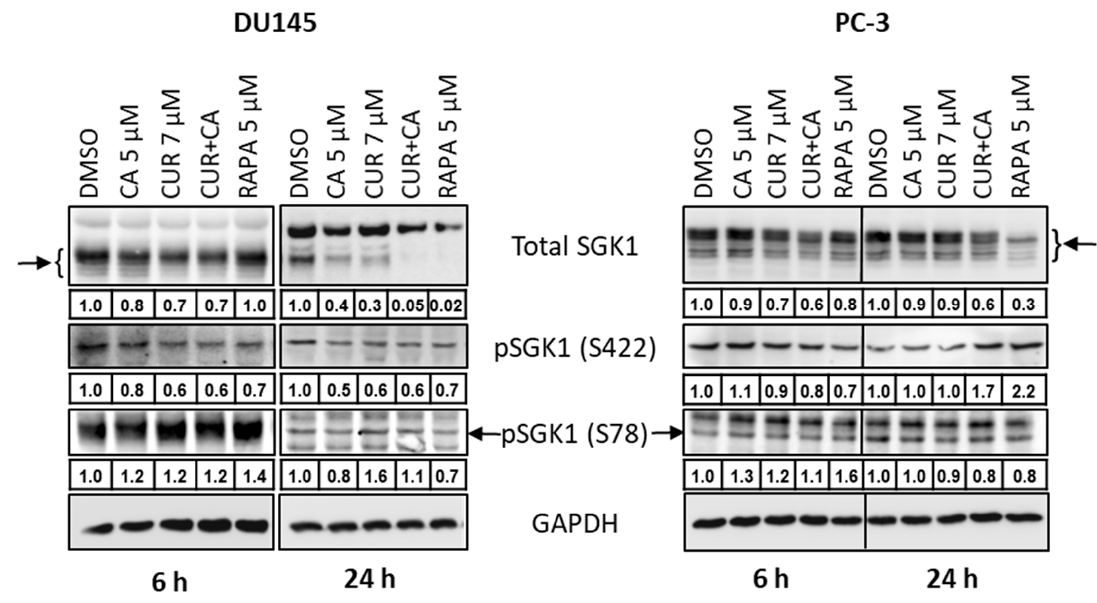
Figure 10. Effects of polyphenols and rapamycin on the protein expression and phosphorylation of serum- and glucocorticoid-regulated kinase 1 (SGK1) in prostate cancer cells. DU-145 and PC-3 cells were cultured with vehicle (DMSO), the indicated concentrations of curcumin (CUR) and carnosic acid (CA), alone and in combination, or the mTOR inhibitor rapamycin, for 6 or 24 h. Cells samples were then subjected to Western blot analysis. Integrated Density Values (IDVs) of the indicated protein bands normalized to IDVs of respective GAPDH bands are shown below corresponding blot images. Representative blots of 3 similar experiments are presented.